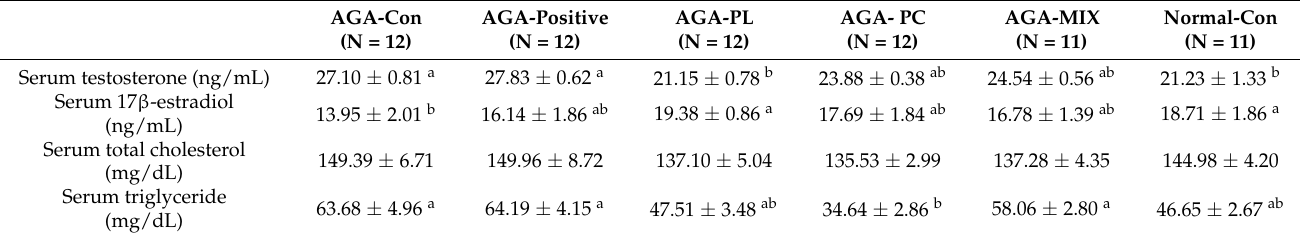
AGA was induced with the application of 0.5% testosterone propionate solution on the back of mice, and AGA-induced mice orally consumed 0.1% PL, 0.1% PC, or 0.1% mixture of PL and PC (1:1, w / w ) in a 43% fat diet (HFD), called AGA-PL, AGA-PC, or AGA-MIX groups, respectively. AGA-induced mice were daily applied with 2% finasteride on the back, as AGA-Positive (positive control). AGA- Positive and AGA-Con (control) mice had 0.1% cellulose (no effective activity in AGA treatment) in an HFD. Normal-Con did not induce AGA and consumed 0.1% cellulose in an HFD. All mice had an 8-week treatment. Values are means ± standard deviations. a,b Different superscripts on the means indicate a significant difference as per a Tukey test at p < 0.05, and no or the same superscripts included on them indicate no significance between the